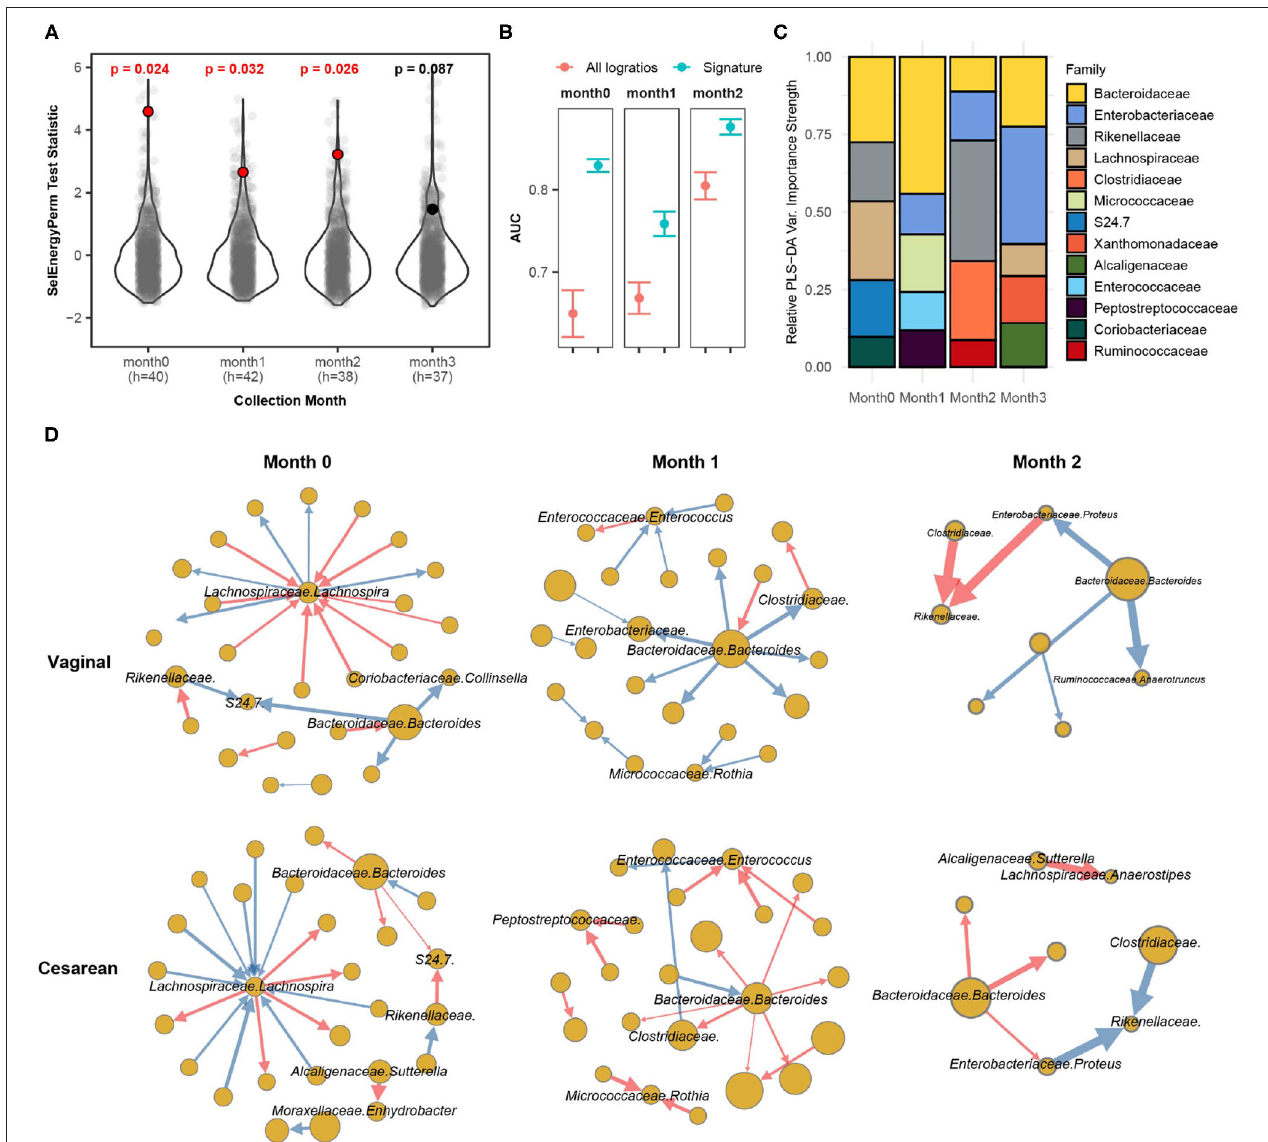
FIGURE 6 | SelEnergyPerm case study examining the association between delivery mode and the gut microbiome composition of infants over the first 3 months of life using 16S data. (A) SelEnergyPerm permutation test (permutations 1,000) results displaying the null distribution of the test statistic (violin and gray points) and the = empirical test statistic (red if significant, black otherwise) with Benjamini-Hochberg corrected p -values. Test statistics values were z -score scaled (by Collection Month) for ease of visualization. (B) AUC comparisons of delivery mode discrimination using PLS-DA. Models were trained with repeated (r 20) 5-fold stratified (delivery = mode and host) cross-validation using either the SelEnergyPerm signature or all logratios. Points represent the mean AUC and error bars indicate the 95% CI. (C) Relative taxa strength by family measuring the importance of each taxon for discriminating between delivery modes across each collection time point. Relative strength was computed using the top 5 nodes derived from the PLS-DA variable importance weighted logratio networks across each collection time. (D) Directed (edges point from numerator to denominator) network of the SelEnergyPerm-derived signature by month and delivery mode weighted by the absolute logratio means [nodes taxa, node size mean strength, edge logratio, edge width logratio mean, red edges negative logratio mean (incoming node more abundant), blue = = = = = edges positive logratio mean (outgoing node more =